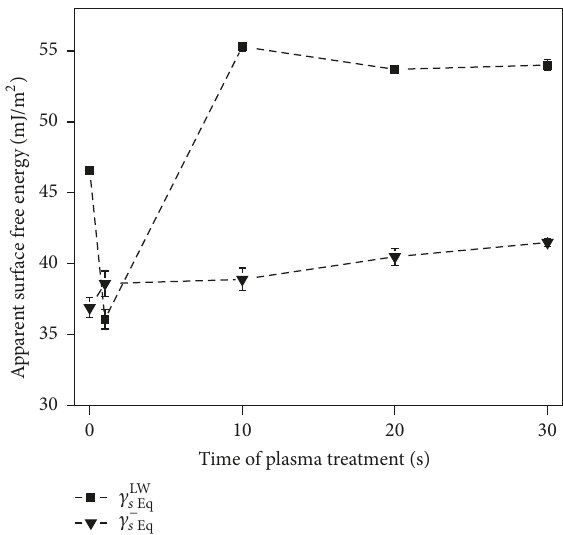
Figure 6: Dispersive 𝛾 LW 𝑠 and electron donor 𝛾 − 𝑠 components of apparent surface free energy calculated from the LWAB approach.